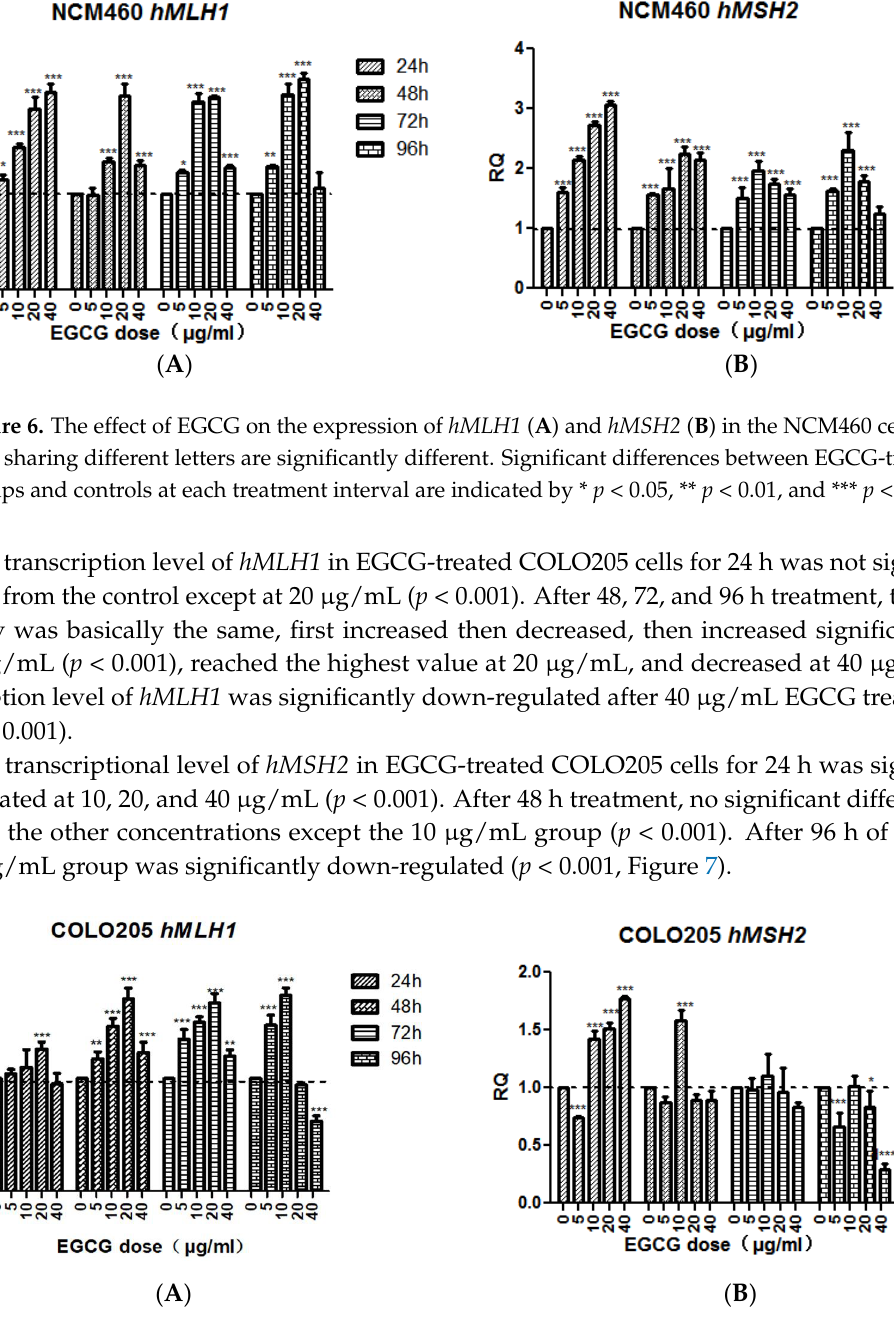
Figure 7. The effect of EGCG on the expression of hMLH1 ( A ) and hMSH2 ( B ) . Bar sharing different letters were significant differences from each other. Significant differences between EGCG-treated groups and controls at each treatment interval are indicated by * p < 0.05, ** p < 0.01, and *** p < 0.001.